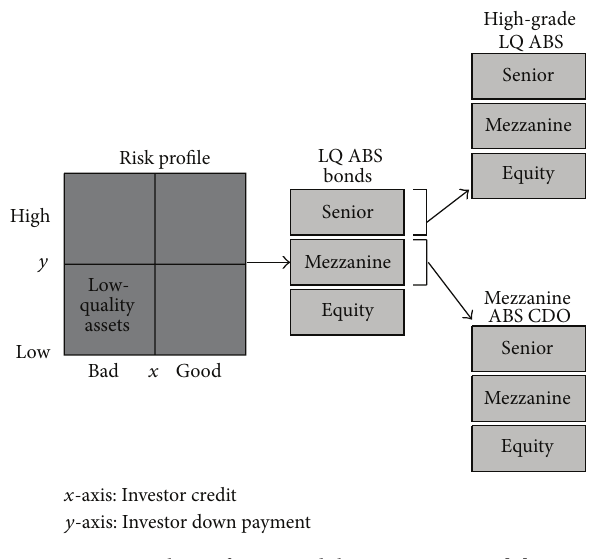
Figure 1: Chain of LQAs and their SAPs; source: